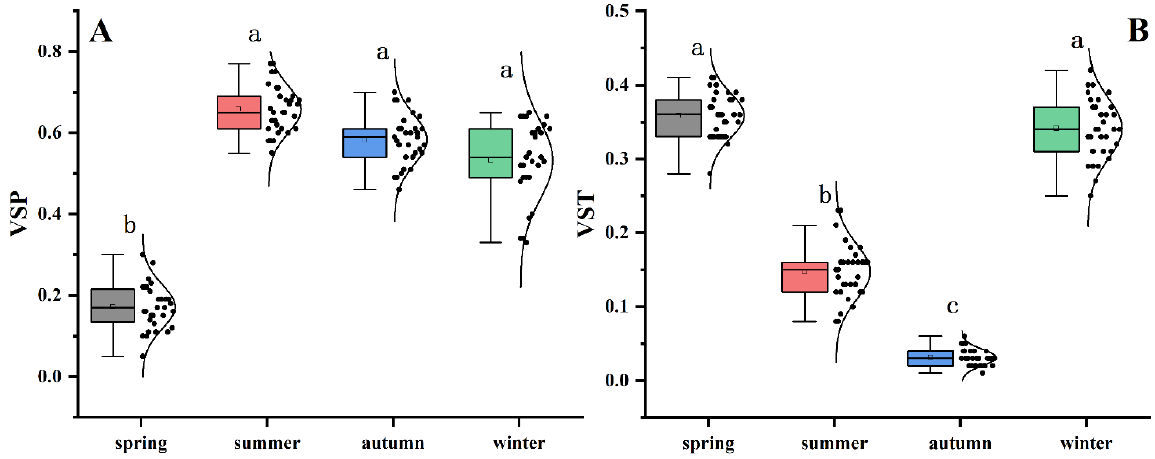
Figure 2. Comparison of the differences in seasonal VSP ( A ) and seasonal VST ( B ) during 1982–2013. The different letters above the error bar indicate significant differences between seasons.